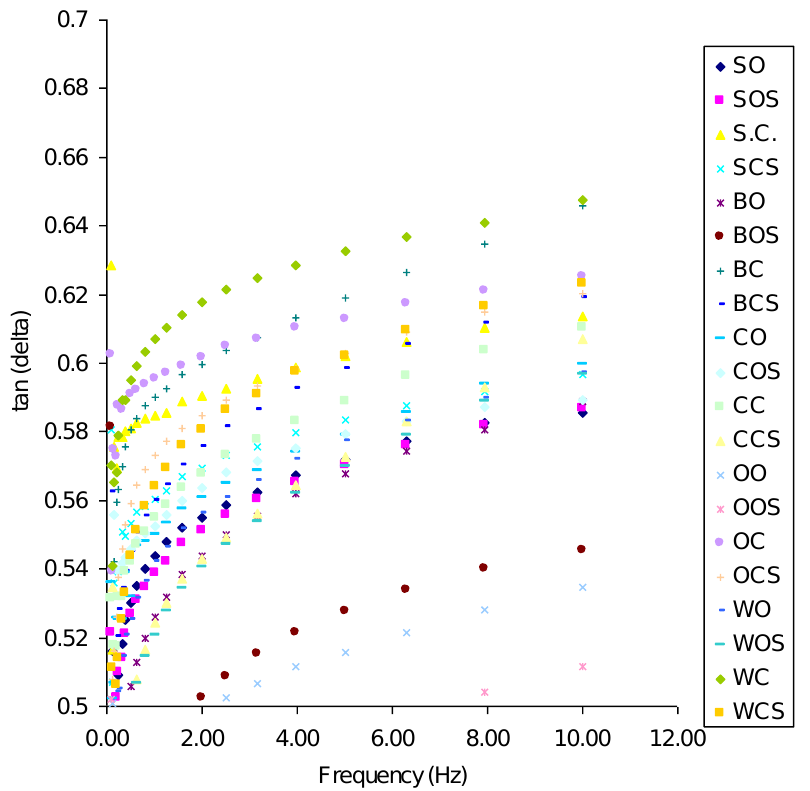
Figure 2. Influence of frequency on loss tangent of different gluten samples (S — sugar beet; B — barley; C — clover; O — oats; W — wheat; O — organic system; C — conventional system; S — sonicated (e.g., BCS — barley in conventional system, sonicated).